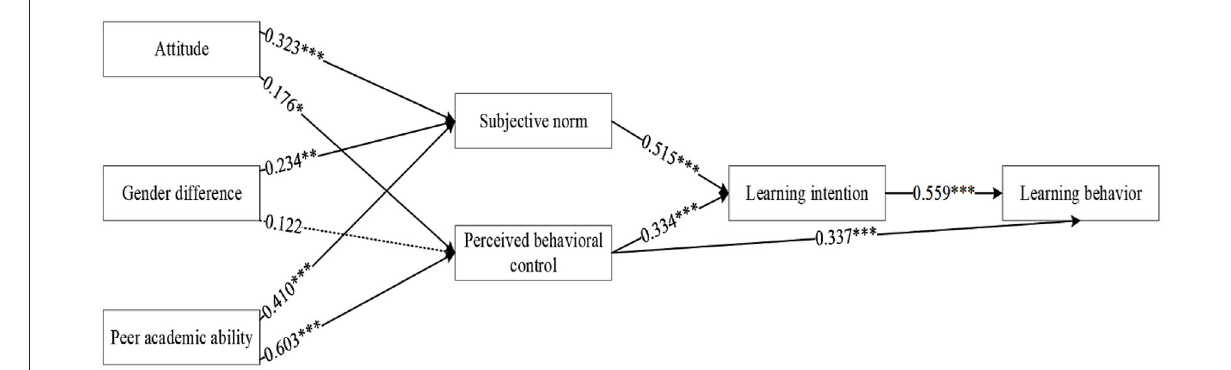
FIGURE4 Overall results from the SEM. χ 2 / df = 4.664, CFI = 0.958, TLI = 0.906, SRMR = 0.049. * p < 0.05; ** p < 0.01; *** p < 0.001.